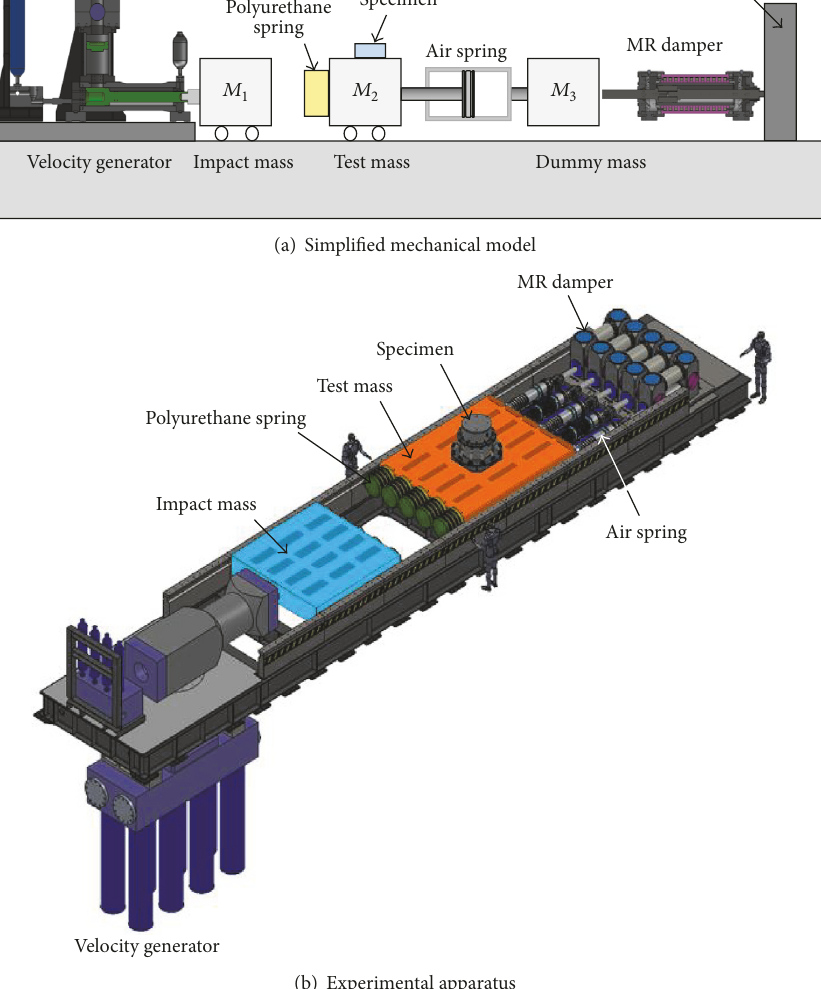
Figure 2: Schematic of the impact testing machine